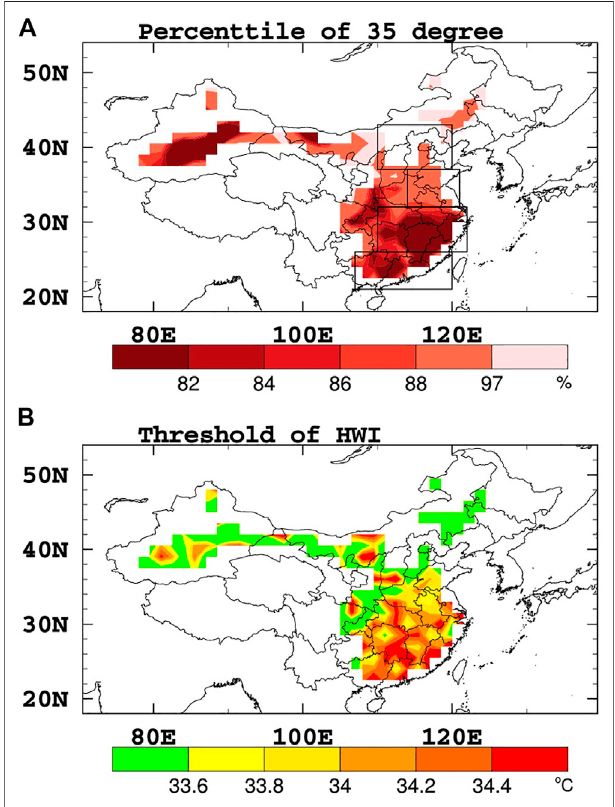
FIGURE1|(A) Thepercentilesofgreaterandequalto35 ℃ dailysurface maximum air temperatures to all summer period (July – September) for each grid and (B) the extreme thresholds of HWI basing the percentiles [in (A) ] of climatological distribution. The four boxes shown in Panel 1A are the regions prone to HWI for Huanan, Yangtze, Huanghuai, and Huabei respectively from South to North of eastern China.